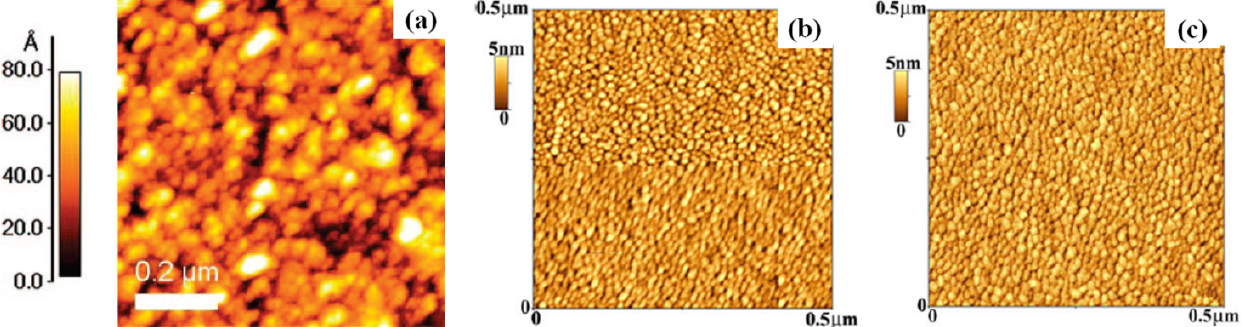
Figure 1. AFM images of: ( a ) 25 nm-thick Au layer evaporated (at room-temperature) onto 11 nm-thick poly(N-vinylcarbazole) spin-coated film on glass; ( b , c ) 2 nm-thick Au layer sputtered (at room temperature) onto 200 nm-thick polystyrene and poly(methyl methacrylate), respectively, spin-coated on Si. ((a): reproduced with permission from [13], Copyright American Chemical Society 2009; (b,c) reproduced with permission from [21], Copyright Springer